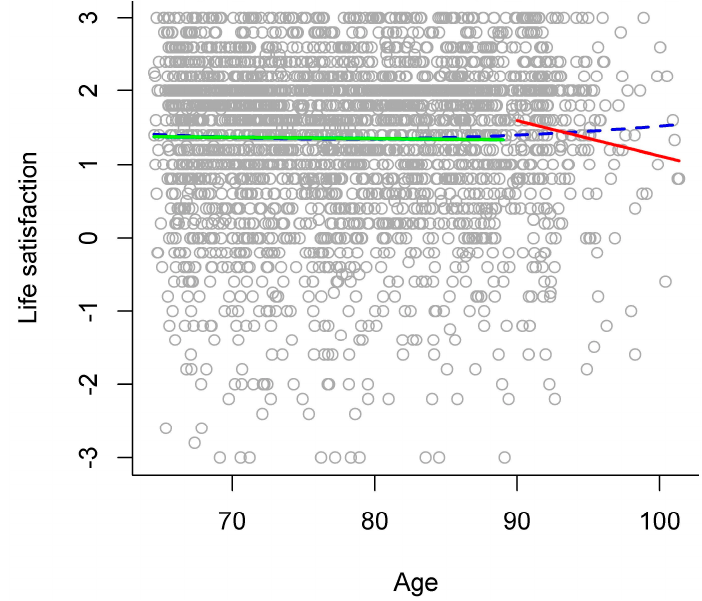
Figure 5. Age relations in life satisfaction. Scores in life satisfaction plotted against chronological age, with different models of age relations: gradual model (blue dashed line) and stage model (young-old adults: green solid line versus old-old adults: red solid line).